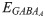
Determination of effective conductances in realistic neuron simulations.a, independence of the E and I conductances on the change of the reversal potentials. The E reversal potential EAMPA varies from −50 mV to 50 mV with ten even increments, and the I reversal potential EGABAA varies from −70 mV to −90 mV with five even increments. The thick blue bar indicates the mean and the thin red bar indicates one standard deviation. The ratio of standard deviation to mean for both conductance values is within 5%. b, Two I-V relations obtained under somatic voltage clamp mode with the I reversal potential EGABAA changing from −80 mV (green) to −90 mV (orange). The data are collected at the time 15 ms after the onset of the stimulus. The voltage value shown in the abscissa is relative to the resting potential. c, a pair of E (red) and I (blue) effective conductances determined by SIM (open circle) and IM (solid circle). The E and I inputs are given simultaneously on the dendritic trunk about 350 μm and 300 μm away from the soma, respectively. Solid curves are the reference conductances obtained under the same individual E or I input given separately. d, the spatial distribution of multiple E (red) and I (blue) inputs on the dendrite. Bar indicates 100 μm. e, E (red) and I (blue) effective conductances determined by SIM (open circle) and IM (solid circle) when the neuron receives multiple inputs. Solid curves are the reference conductances obtained by the same E or I inputs given separately. The input locations are shown in d and the input times at each location are uniformly distributed from 0 ms to 1000 ms with a rate of 100 Hz. f-i, spatial dependence of the relative error for the E and I conductance measurement. Here, the locations for a pair of E and I input of constant conductances are scanned across the dendrite. The location distance is measured from the soma. f-g are the error of E conductance measured by IM and SIM, respectively, and h-i are the error of I conductance measured by IM and SIM, respectively. They share a color bar to indicate the percentage of error. In i, the large white area, which corresponds to negative conductance values, again illustrates the failure of the traditional method.